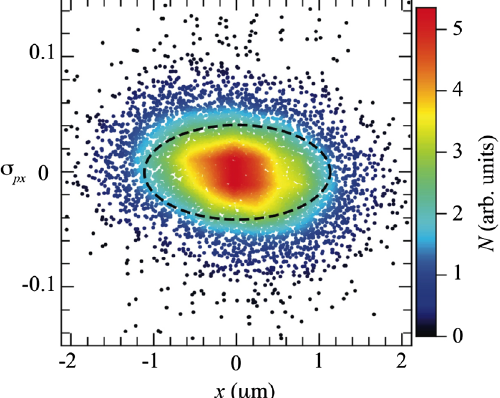
FIG. 8. Transverse phase space (out of the plane of laser polarization) of ionized electrons after ionization region ≃ 1 . 9 , with transverse rms emittance ϵ k β L i (Two-color ionization injection parameters are the same as Fig.